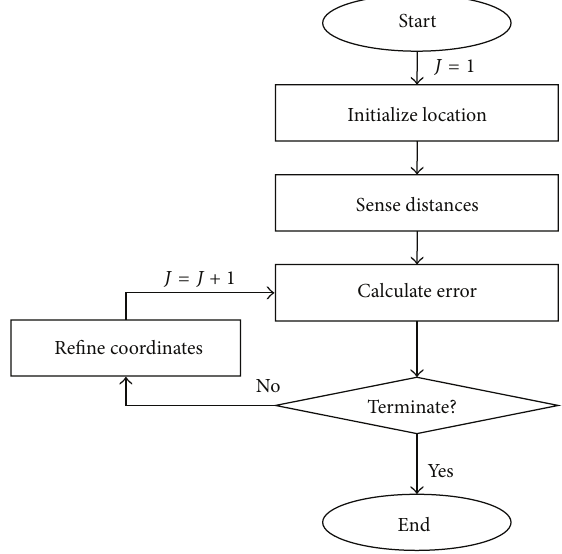
Figure 3: RFID 3D location sensing algorithm.